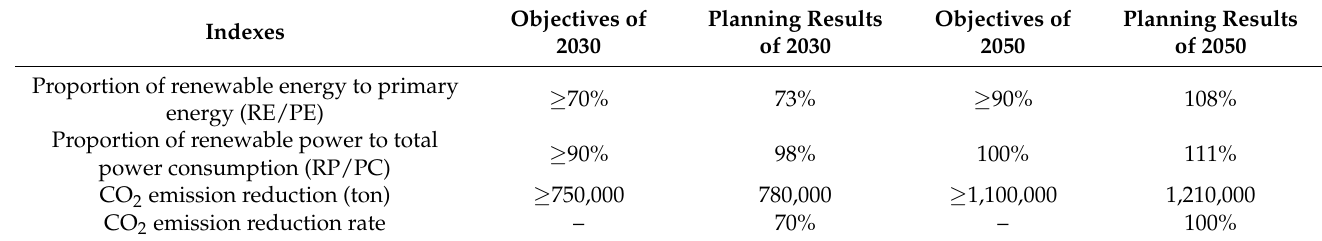
Table 2. The summary of major planning